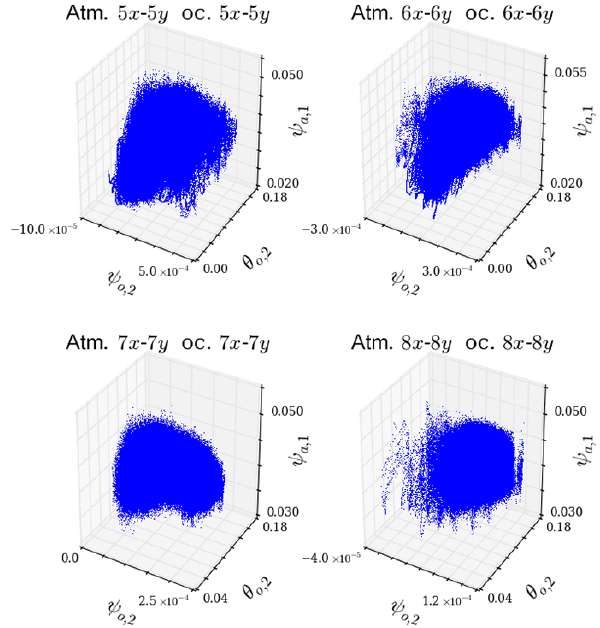
Figure 2. Cross section of the attractors for various model resolu- tions (continued from Fig.